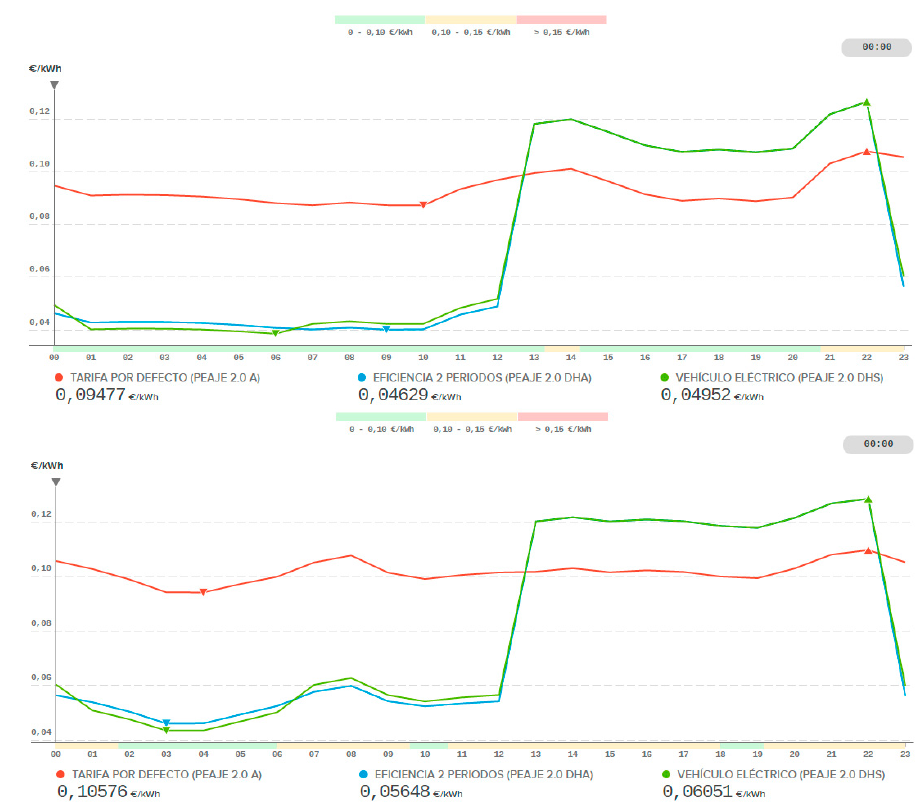
Figure 1. Voluntary Price for the Small Consumer for Spain, 19 (Sunday) and 20 (Monday) June 2016, as shown in [12]. Default tariffs (red) are 0.09477 and 0.10576 €/kWh, two periods (blue) are 0.04629 and 0.05648 €/kWh and Electric Vehicle (green) are 0.04952 and 0.06051 €/kWh, respectively.